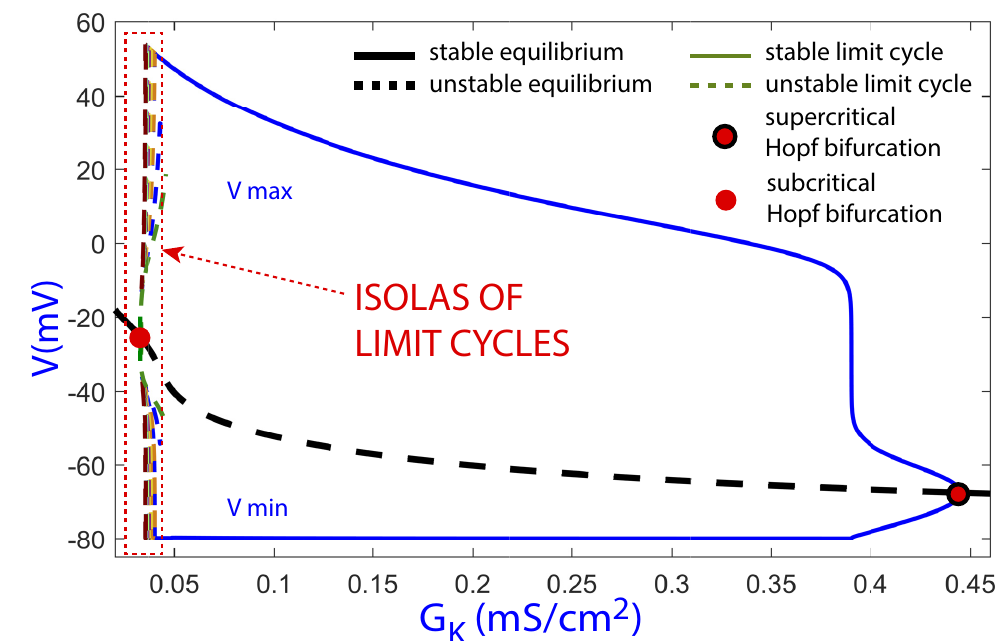
Figure 7. Bifurcation diagram using G k as the continuation parameter for a large interval of G k values to show the Hopf bifurcations. Black thick lines correspond to equilibria, while color lines correspond to limit cycles. Continuous lines represent stable invariants, while discontinuous lines represent unstable